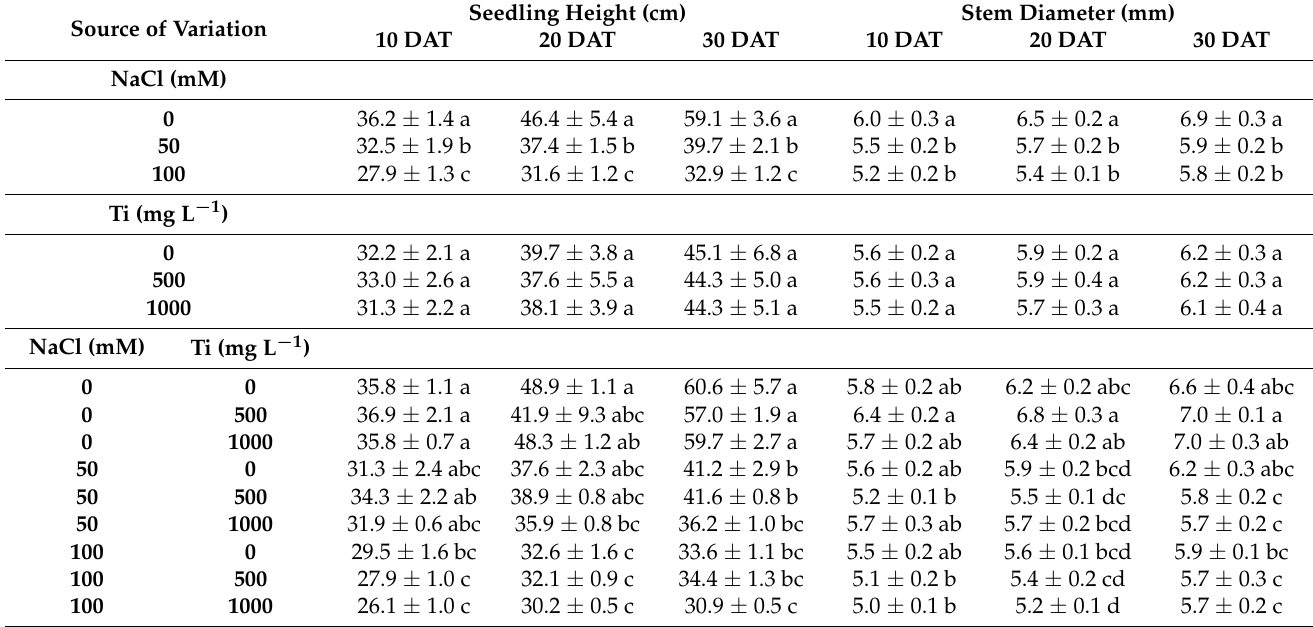
Table 1. Main and interaction effects of NaCl and TiO 2 on seedling height and stem diameter of tomato ( Solanum lycopersicum L.) cv. Rio